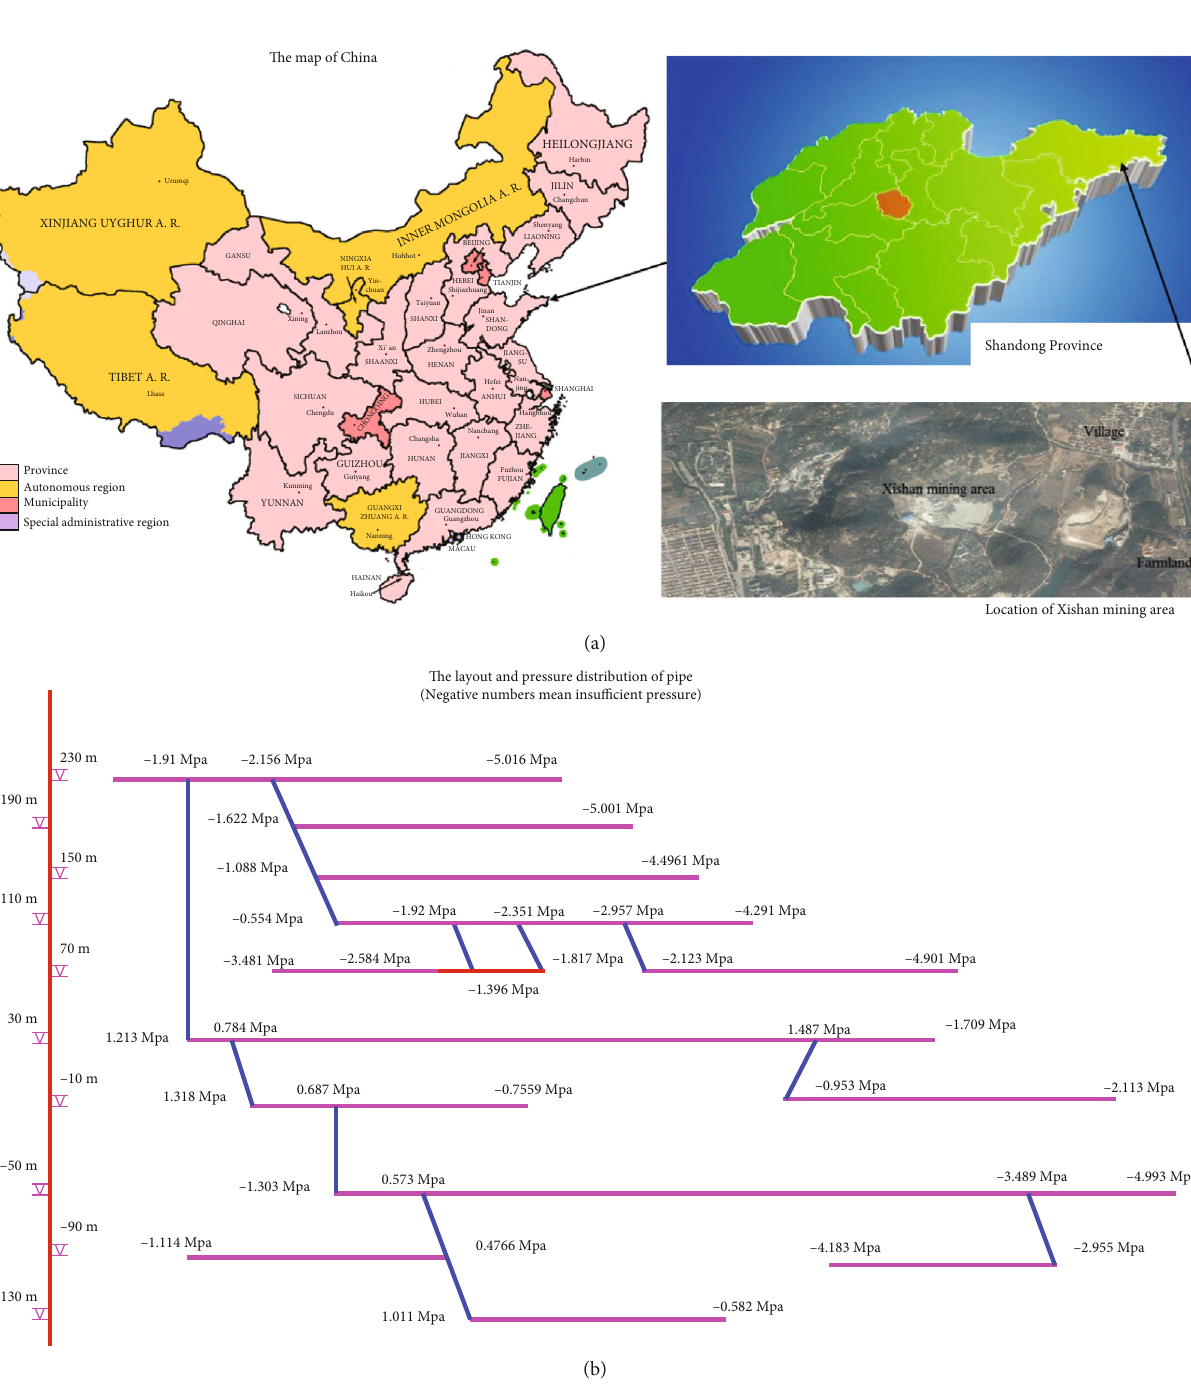
Figure 5: (a) The geographical location of the Xishan mining area and (b) the layout and pressure distribution of pipe network of Xishan mining